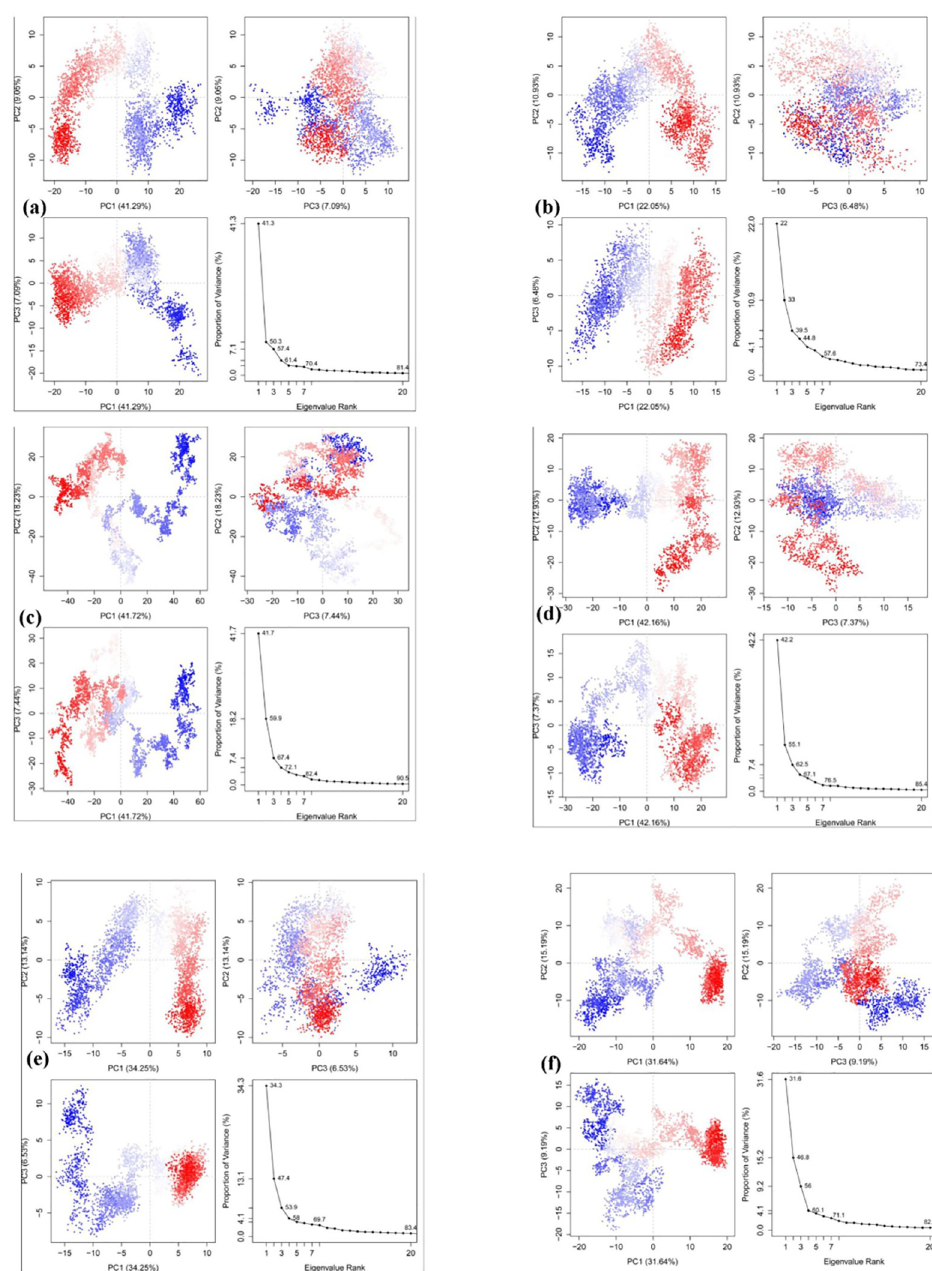
Fig 6. PCA analysis for ( a ) CDK-2_cmpd44 ( b ) CDK-6_cmpd59 ( c ) Topoisomerase-I_cmpd37 ( d ) Topoisomerase- II_cmpd37 ( e ) Bcl-2_cmpd46 ( f )